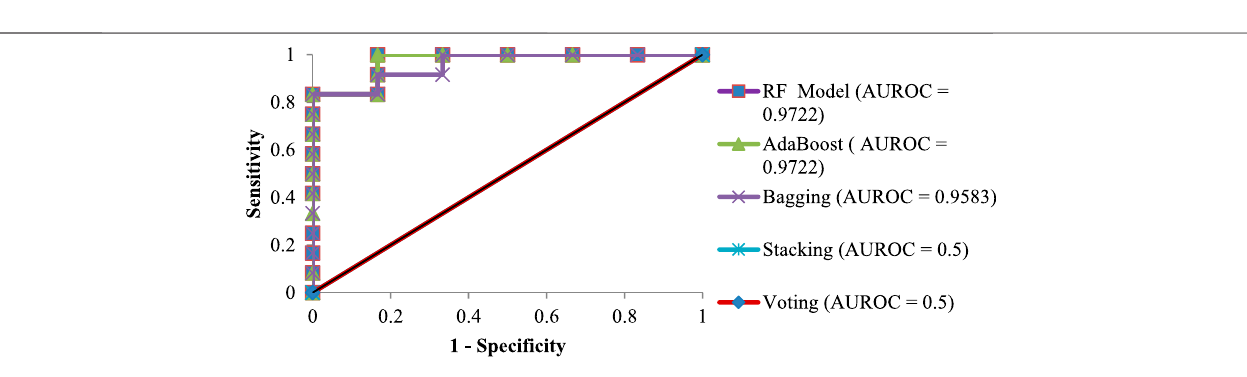
FIGURE 5 | ROC curves for individual ML techniques in the test dataset.